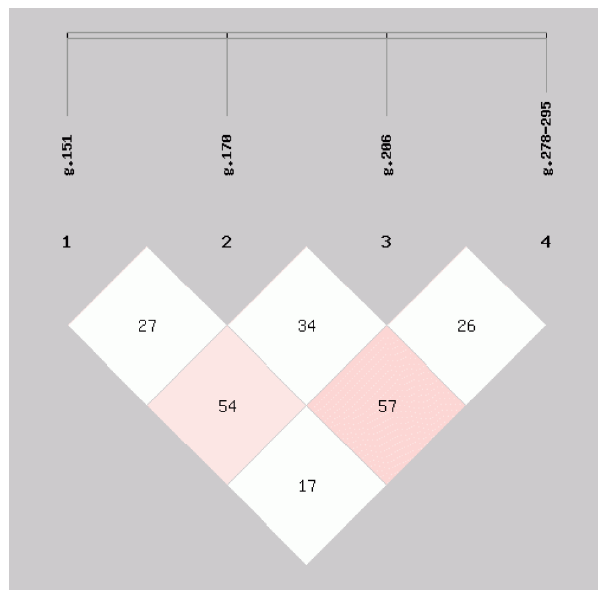
Figure 2. Linkage disequilibrium (LD) plot of the VLDLR gene in Gaoyou ducks. The colour scheme is according to SHEsis r 2 scheme. Numbers in each cell stand for the pairwise r 2 value (%) between the corresponding